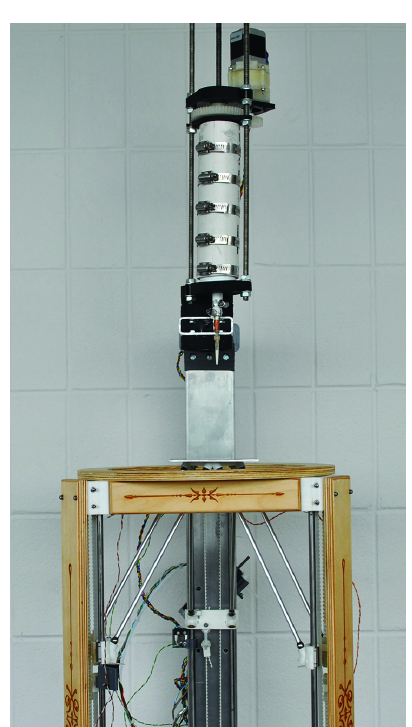
Figure 15. Customizable gasket design for use in 3-D printing.